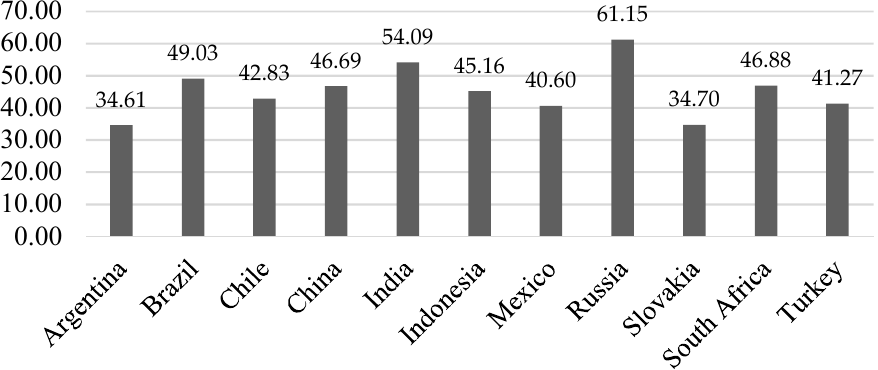
Figure 1. Social entrepreneurship index (SEPR) in emerging economies of the sample in 2021 (as a result of 2020), points 1–100. Source: Compiled by the authors based on data from the Institute of Scientific Communications (2021).